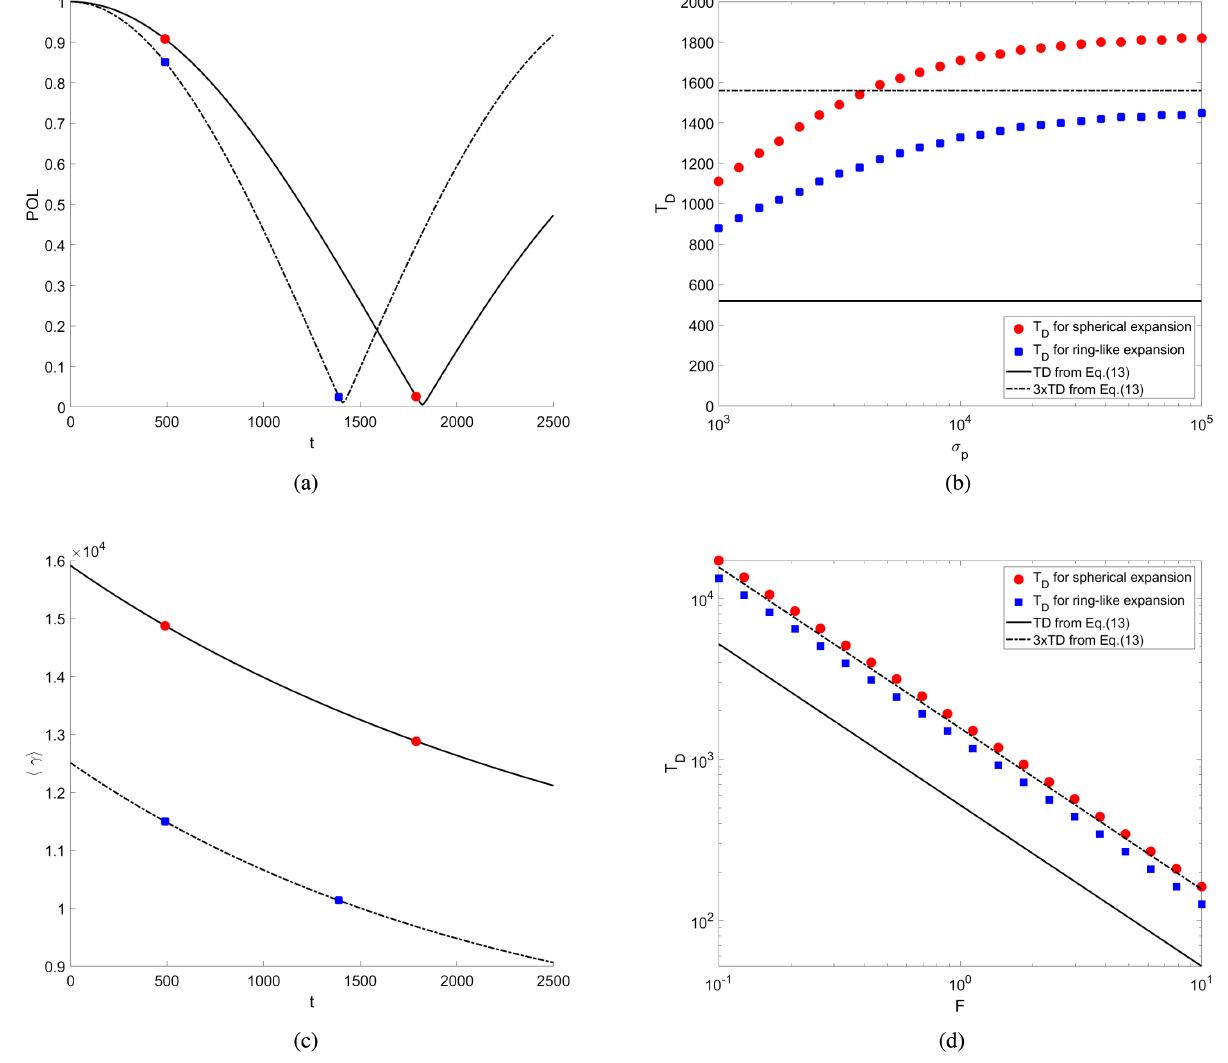
FIG. 5. 5(a): Temporal evolution of j P j from Eq. (1) of a radially expanding electron cloud (black solid line) and a cylindrically ¼ 10 4 and j E j ¼ E expanding cloud (black dashed line) for σ 0 . The blue (squared) and red (dotted) times correspond to the spin p distributions in Figs. 4(c), 4(d), 4(e), and 4(f). 5(b): Simulated depolarization time [red (dots) and blue (squares)] compared to the scaling law from Eq. (13) (black solid line) and a more precise estimation (black dashed line) in dependence of the initial momentum deviation. 5(c): Temporal evolution of the mean energy in a radially expanding electron cloud (black solid line) and a cylindrically expanding cloud ¼ 10 4 . The blue (squared) and red (dotted) times correspond to the spin distributions in Figs. 4(c), 4(d), 4(e), (black dashed line) for σ p and 4(f). 5(d): Simulated depolarization time [red (dots) and blue (squares)] compared to the scaling law from Eq. (13) (black solid line) and the more precise estimation (black dashed line) in dependence of the maximum field strength F for a constant initial momentum deviation of σ p ¼ 10 4